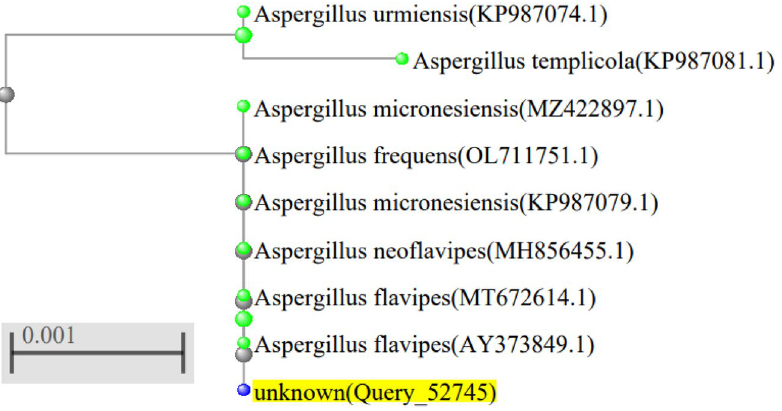
Figure 1. Phylogenetic tree analysis of obtained ITS4 sequence (NCBI); the analyzed sequence is highlighted.